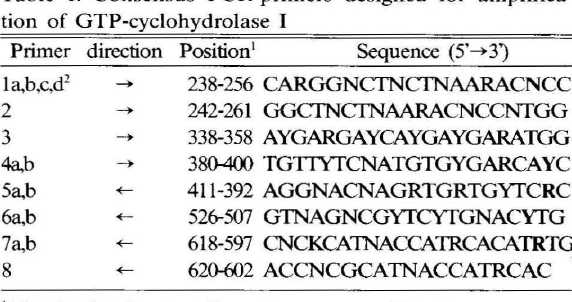
Table 1. Consensus PCR-primers designed for amplifica